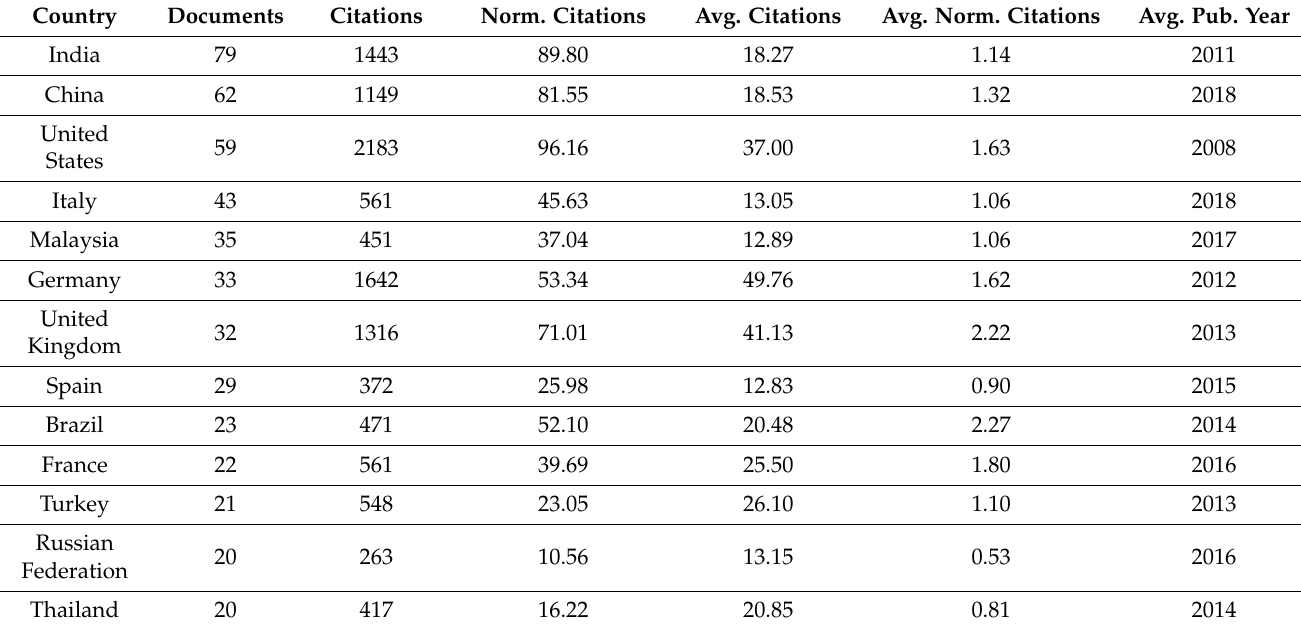
Table 4. Quantitative summary of impact of sources.